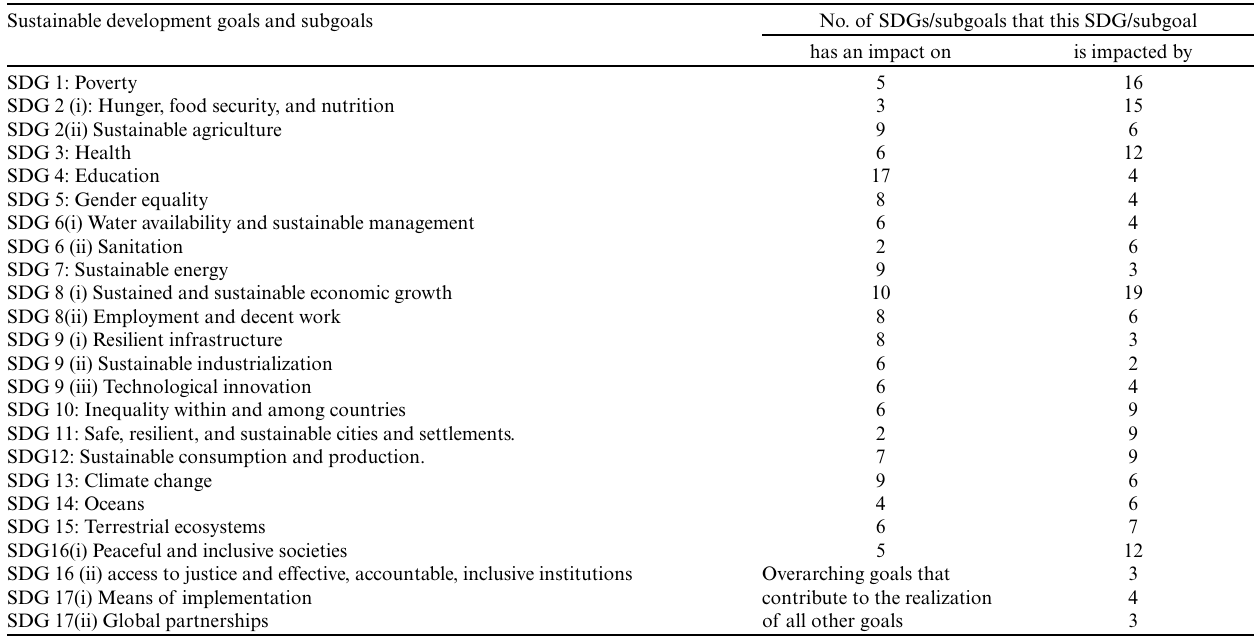
Table 1. Number of links across SDGs and subgoals. The table sets out the number of SDGs that each SDG (or subgoal) has an impact on and the number of SDGs (or subgoals) that impact on the realization of each SDG (or subgoal). Sustainable development goals and subgoals No. of SDGs/subgoals that this SDG/subgoal has an impact on is impacted by SDG 1: Poverty 5 16 SDG 2 (i): Hunger, food security, and